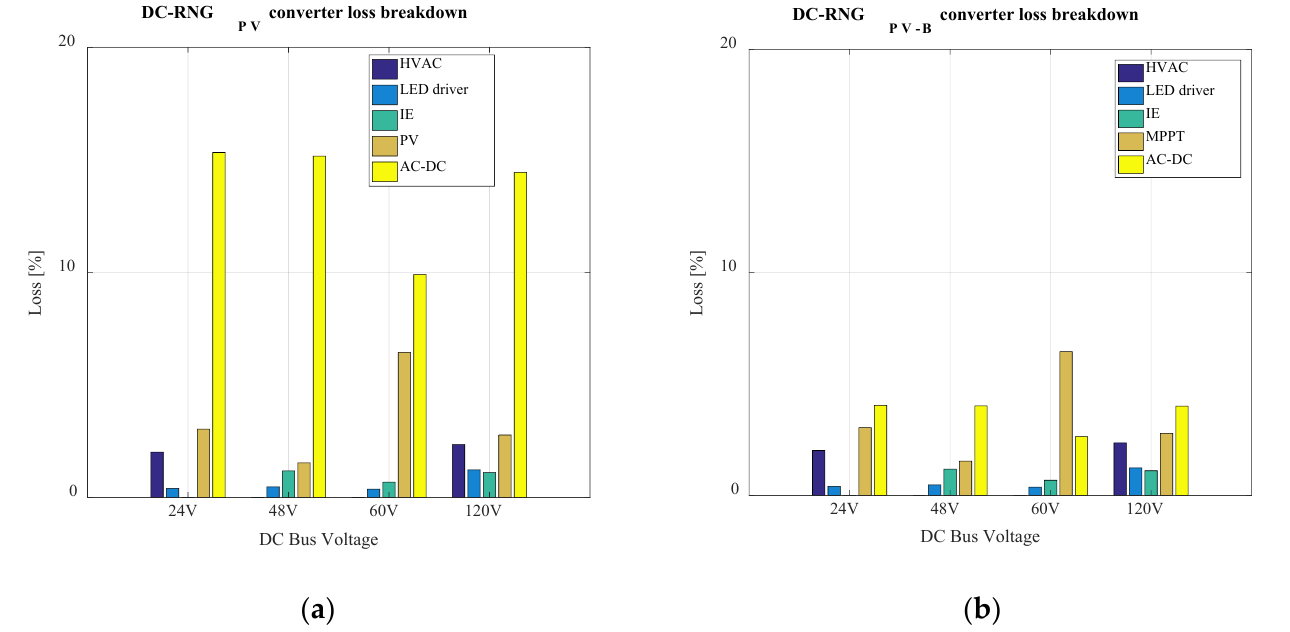
Figure 9. Converter loss breakdown: ( a ) without batteries, ( b ) with batteries.